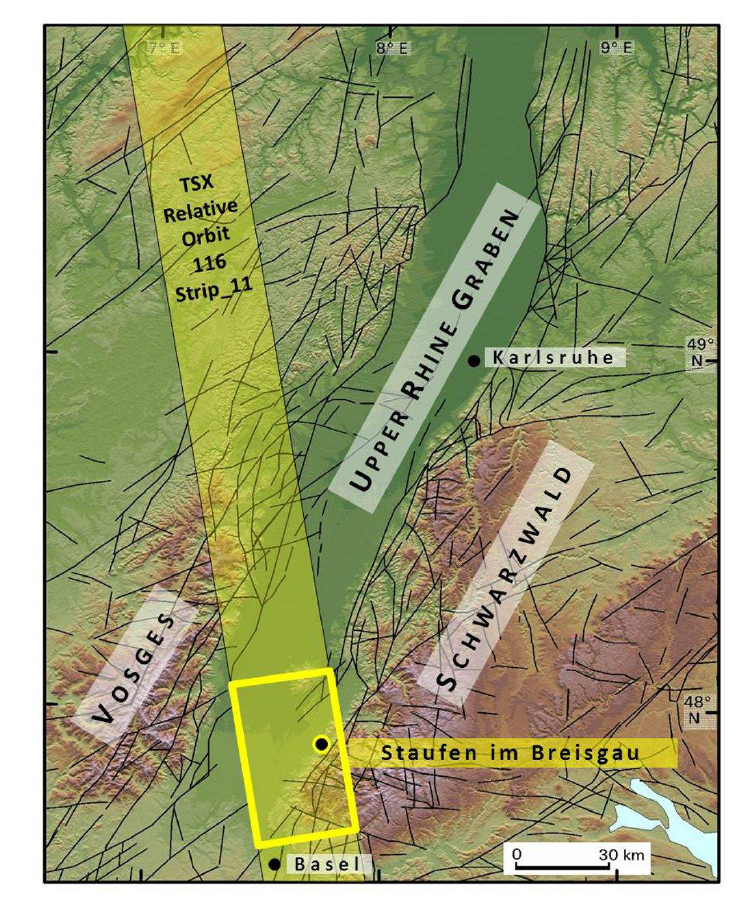
Figure 1. Location of the city of Staufen and the regional lineaments. The Background Digital Elevation Model (DEM) is based on data from the Shuttle Radar Topography Mission (SRTM). The orbit path of the TerraSAR-X satellite (TSX) is shown, and the yellow frame indicates the boundaries of the Spaceborne Synthetic Aperture Radar (SAR) images acquired for this